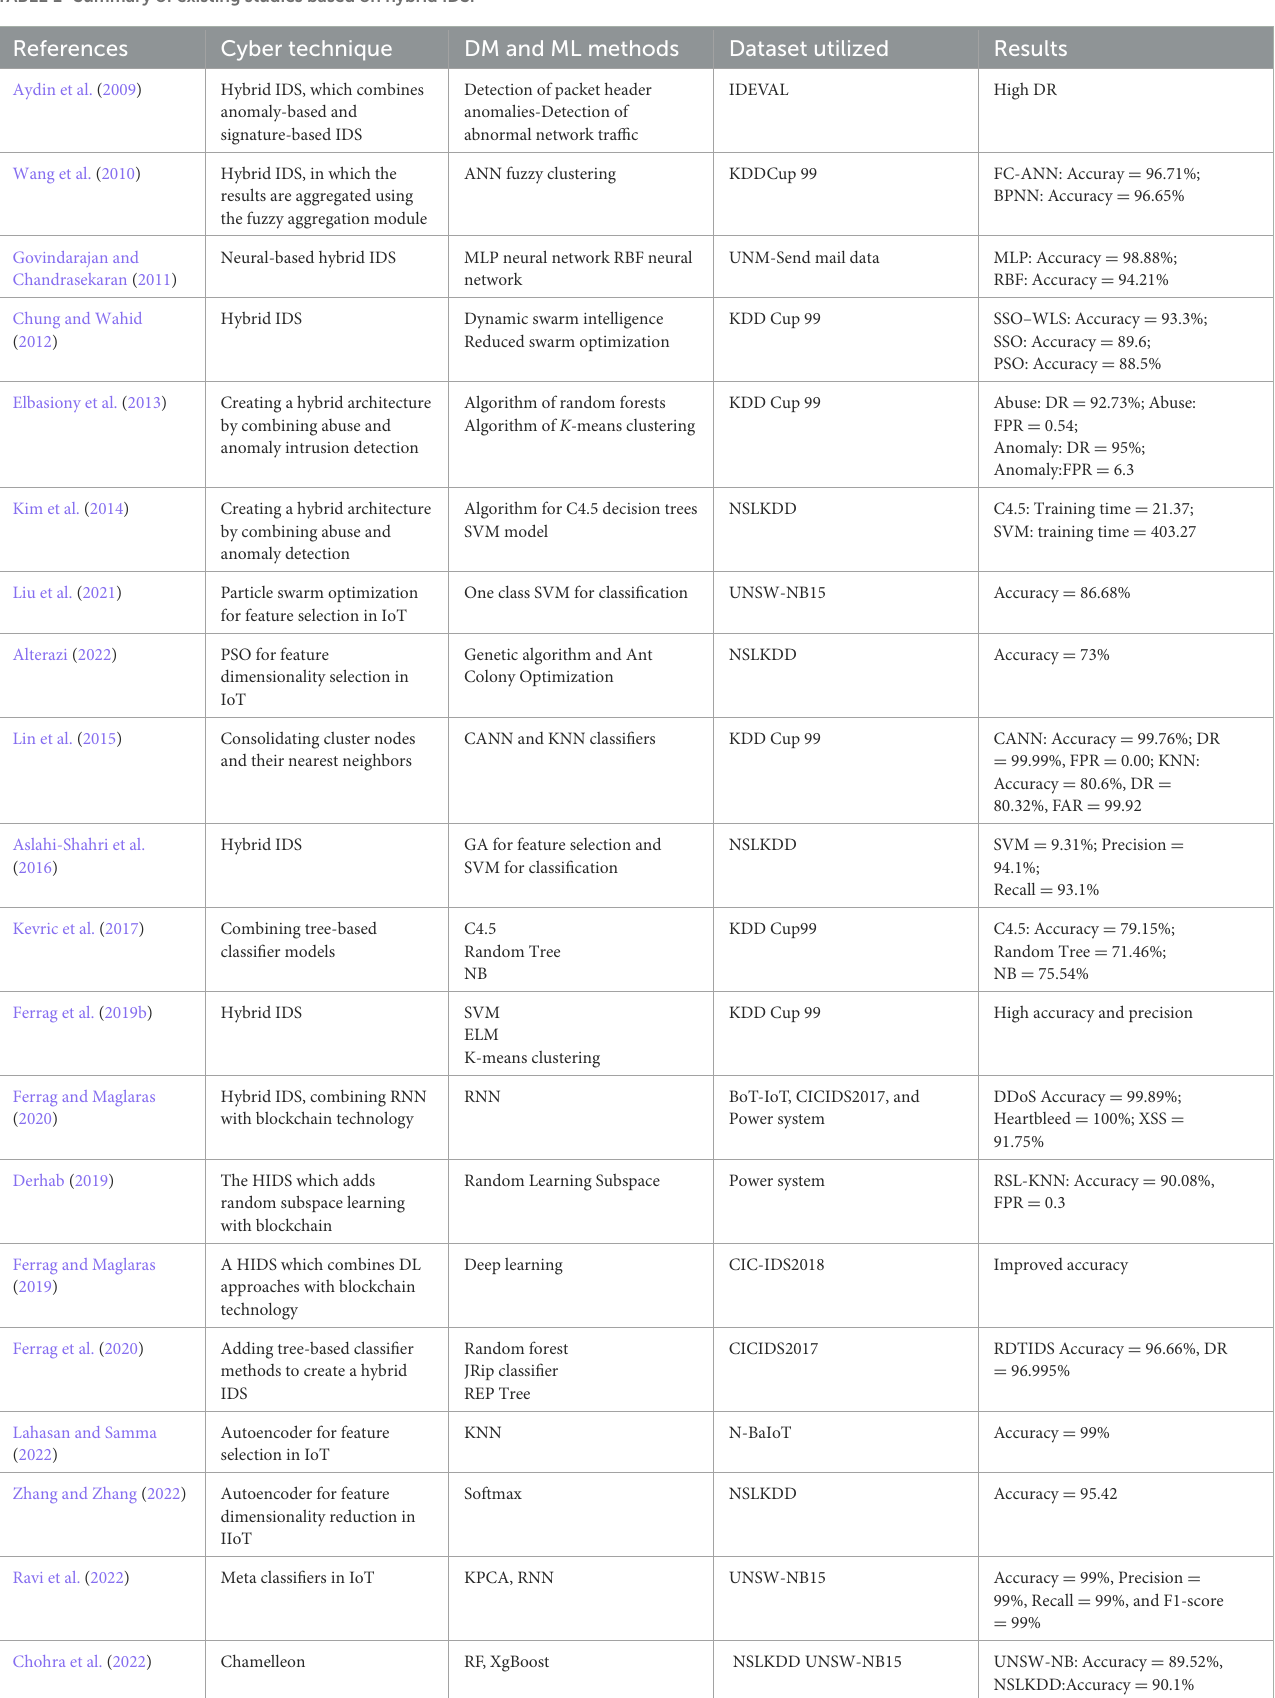
TABLE 1 Summary of existing studies based on hybrid